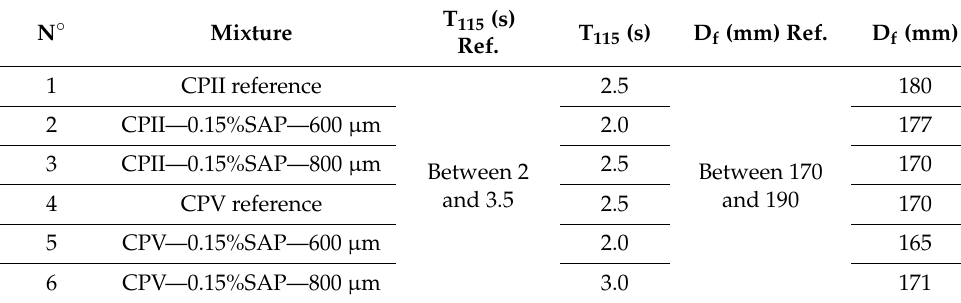
Table 5. Results of the mini slump test.